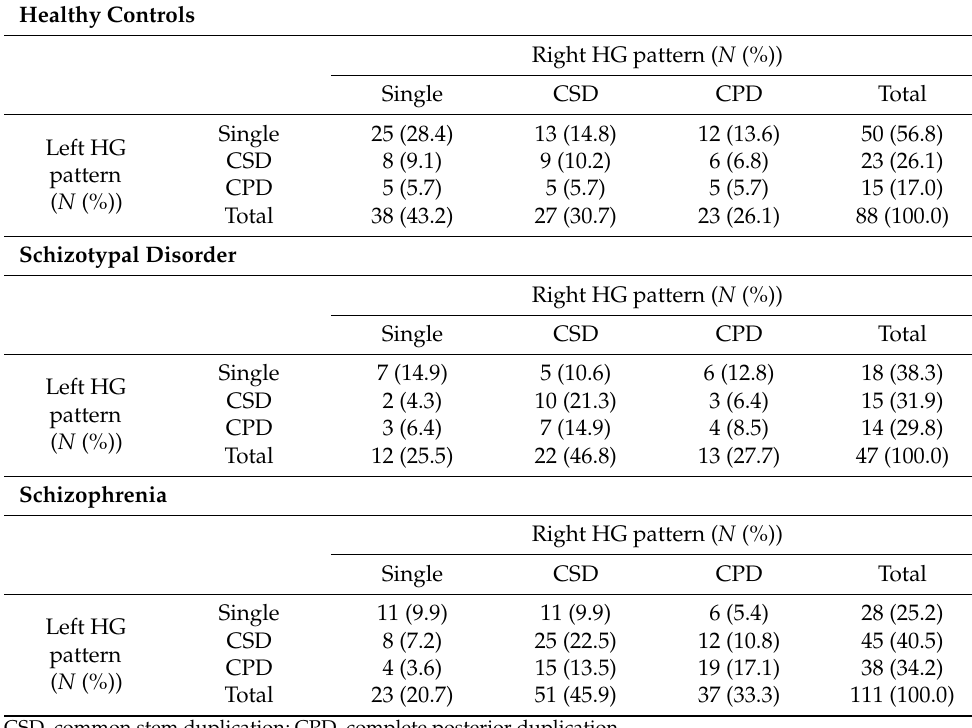
Table 2. Gyrification pattern of Heschl’s gyrus (HG) in subjects.